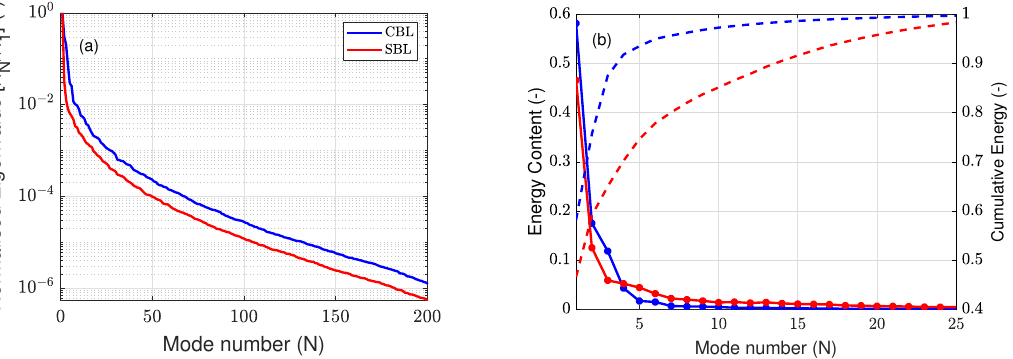
Figure 4. Eigen value distributions ( a ) and the energy contribution of each mode ( b ) for the unstable and stable cases.